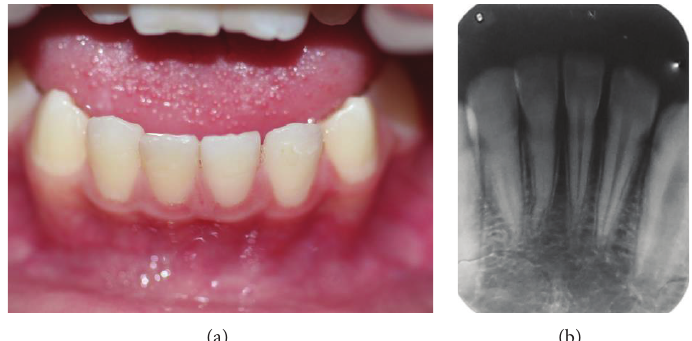
Figure 7: (a) Five-year clinical follow-up. (b) Radiographic image after 5 years of the trauma. Full closure of the apexes and marked obliteration of the root canal